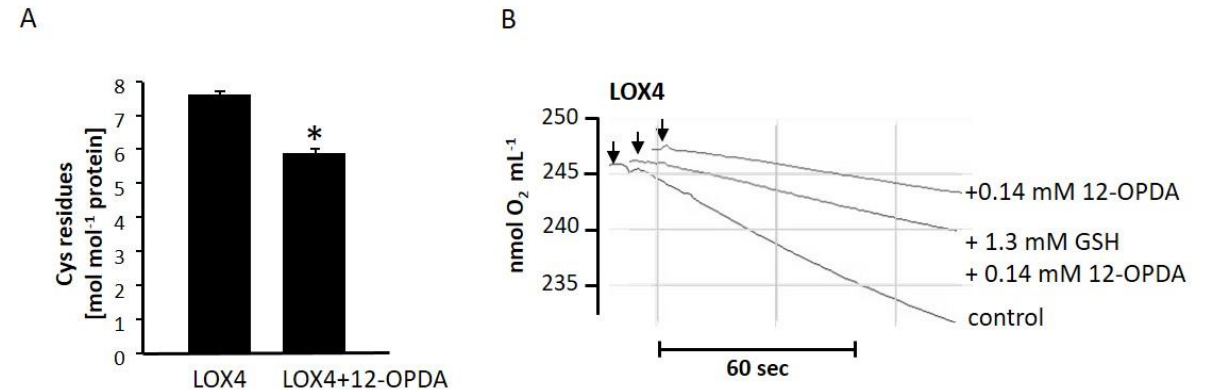
Figure 7. Involvement of thiols in the interaction of LOX4 with 12-OPDA. ( A ) Free thiols of LOX4 incubated with 12-OPDA. Asterisks indicate a significant difference ( p ≤ 0.05) in comparison to control incubate (12-OPDA solvent), calculated using one-way ANOVA with post hoc Tukey HSD. ( B ) O 2 -electrode recordings on the effect of GSH on the efficacy of the herein-identified LOX inhibitor 12-OPDA. GSH or GSH solvent (40 mM K-Pi, pH 8.0) was pre-incubated for 5 min with LOX4 before 12-OPDA as indicated by the arrows was added to the mixture. After 10 min, the incubation mixture was injected into 1.8 mL 20 µ M LeA at 25 ◦ C. The recording of LOX4 incubated with 40 mM K-Pi, pH 8.0 and solvent is shown as a control. The three recordings were performed thrice with the same result.